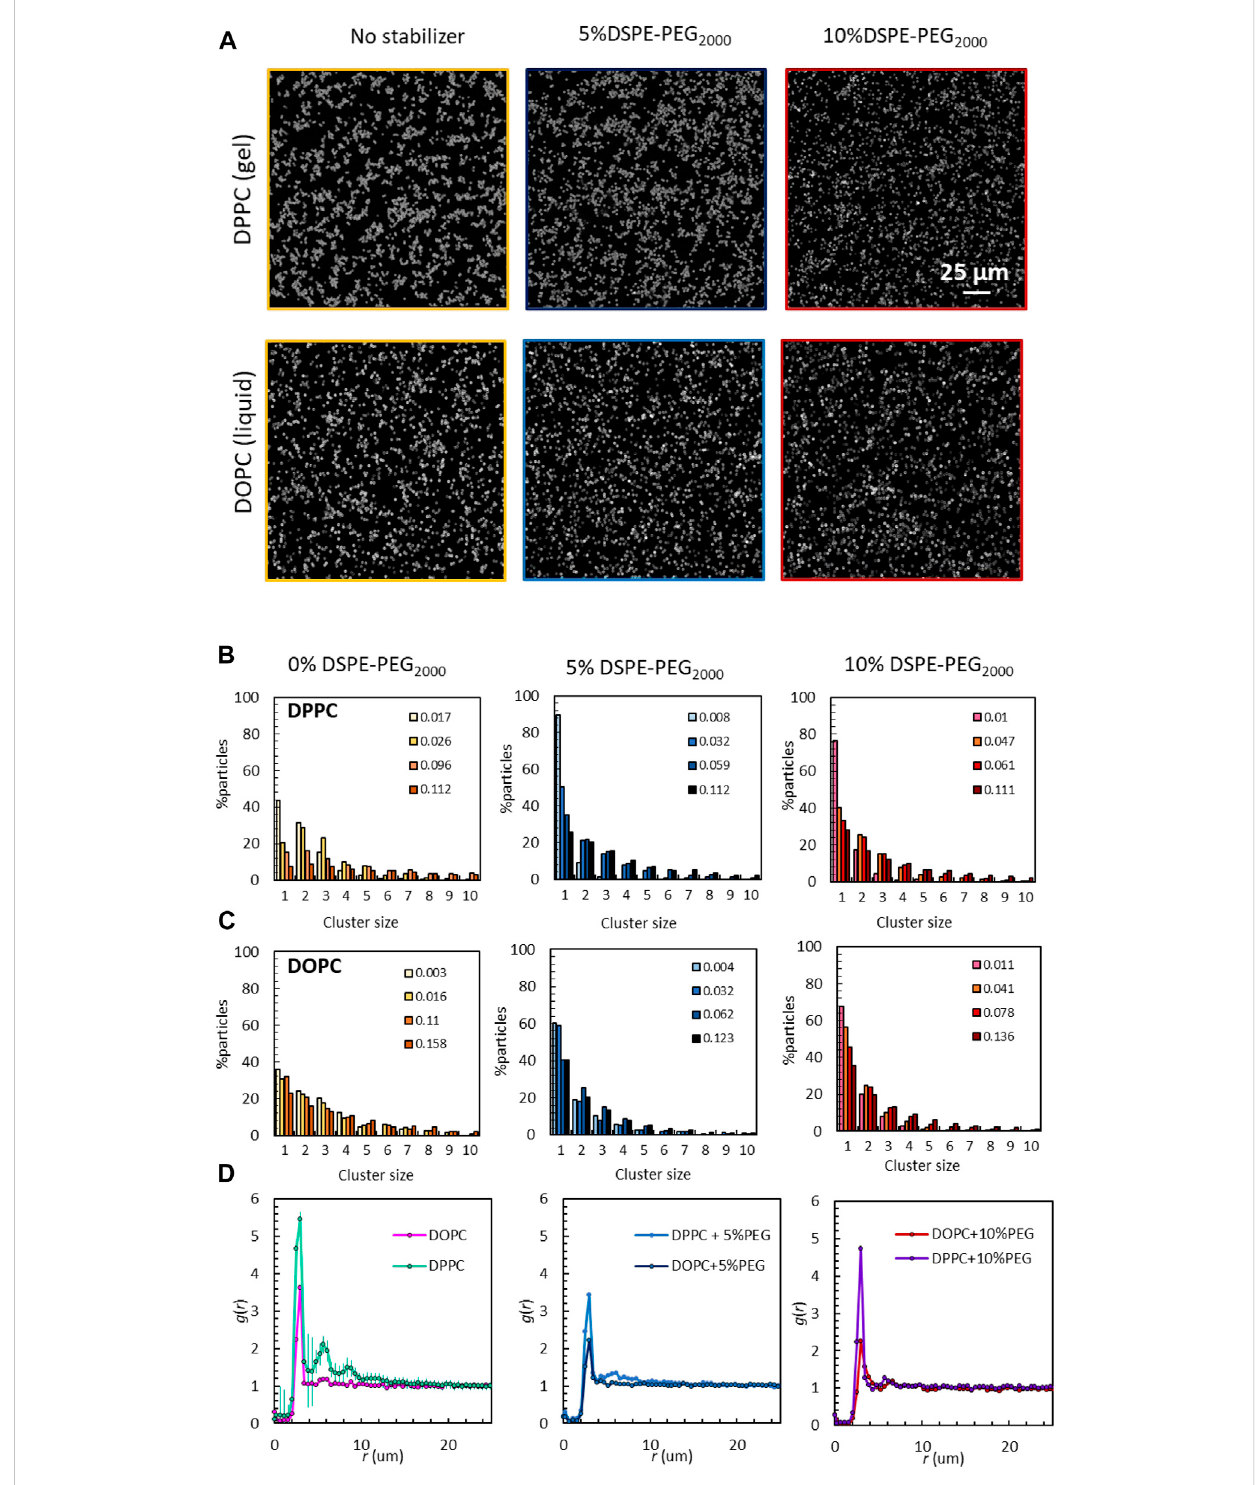
FIGURE 2 (A) confocal microscopy images of DOPC and DPPC CSLBs with 0, 5 and 10%DSPE-PEG 2000 at φ = 0.11. (B – C) Cluster size distributionfor (B) DPPC CSLBs(gel)and (C) DOPCCSLBs( fl uid)with0(left/yellow),5(middle/blue)and10%(right/red)membraneboundDSPE-PEG 2000 forareafractionsranging from dilute to concentrated. (D) Comparison of probability density functions of DPPC and DOPC CSLBs at φ = 0.11 with (left panel) 0% DSPE-PEG 2000 (middle panel) 5% DSPE-PEG 2000 and (right panel) 10% DSPE-PEG